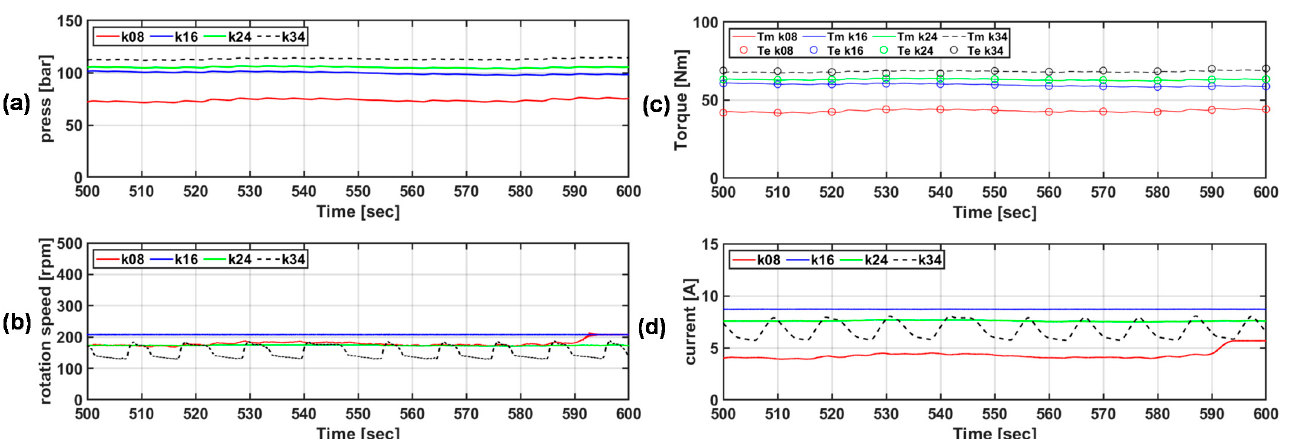
Figure 22. The result of comparing the generation amounts according to the torque coefficient of the optimal torque control algorithm under irregular wave conditions ( H s = 0.75 m, T p = 4.75 s) (legends indicate torque coefficients). Figure 23 shows the power generation performance according to the torque coeffi- cient of the optimal torque control algorithm under irregular wave conditions. In case A ( k = 0.08) with the lowest torque coefficient, the pressure was also low because the load